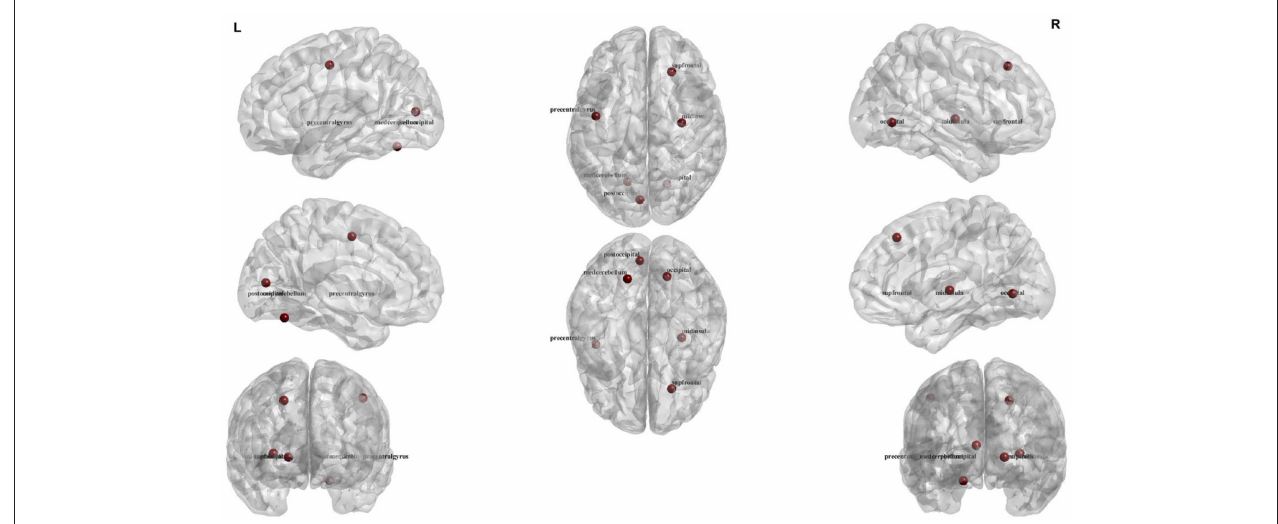
FIGURE 3 | Illustration of the six regions corresponding to top six rs-fMRI features for four-group (AD, HC, MCI-C, and MCI-NC) classification.